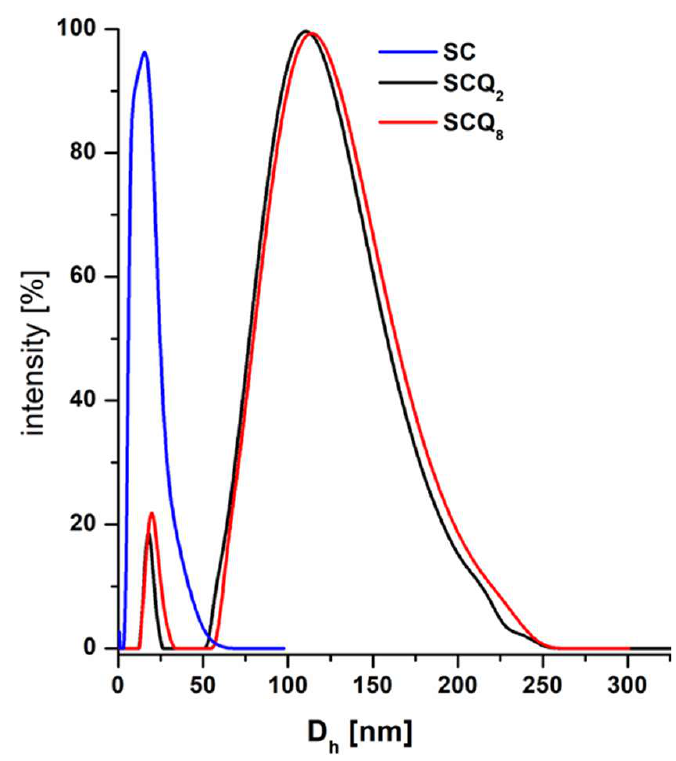
( A ) bromoethane (sample SCQ 2 ) and ( B ) 1-bromooctane (sample SCQ 8 ) (D 2 O, 600 MHz).